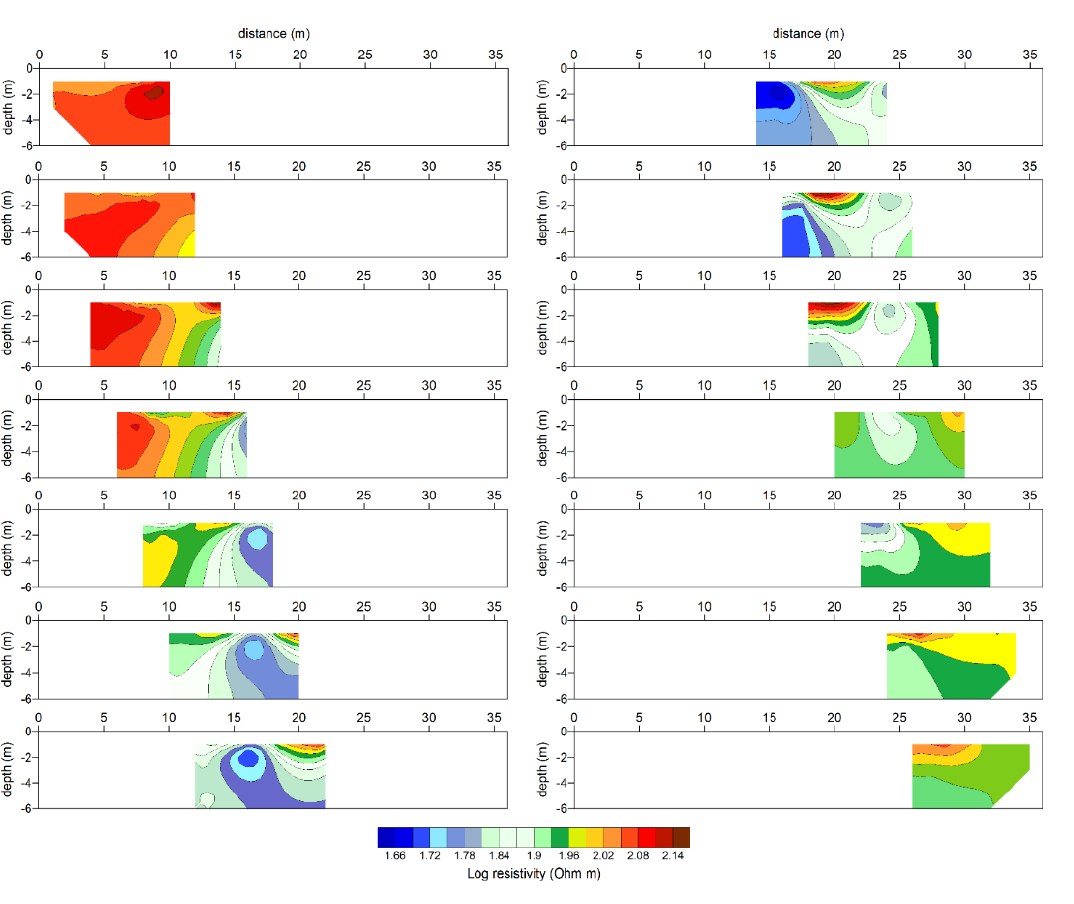
Figure 6. Extraction of the N q tests by a stepwise displacement of 2 m of a 10 m wide data window along the array axis. The reduced sections are classical PERTI results over the whole set of tests within each window.